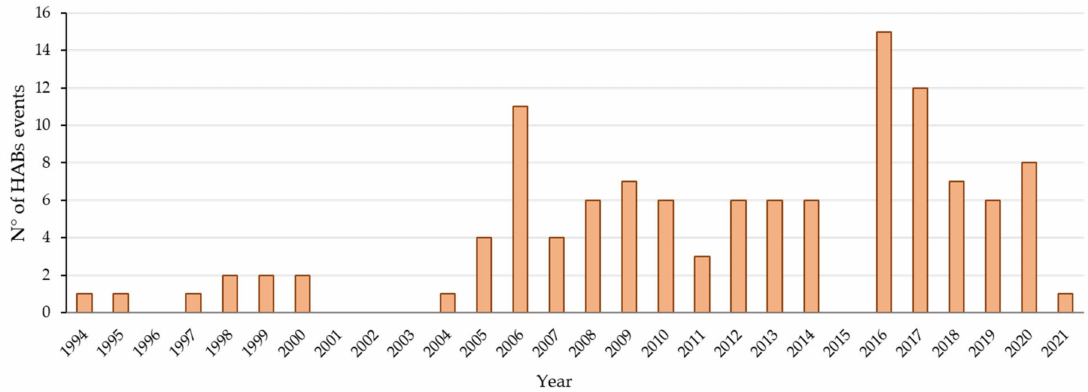
Figure 11. Distribution of HABs events of Pseudo-nitzschia per year in